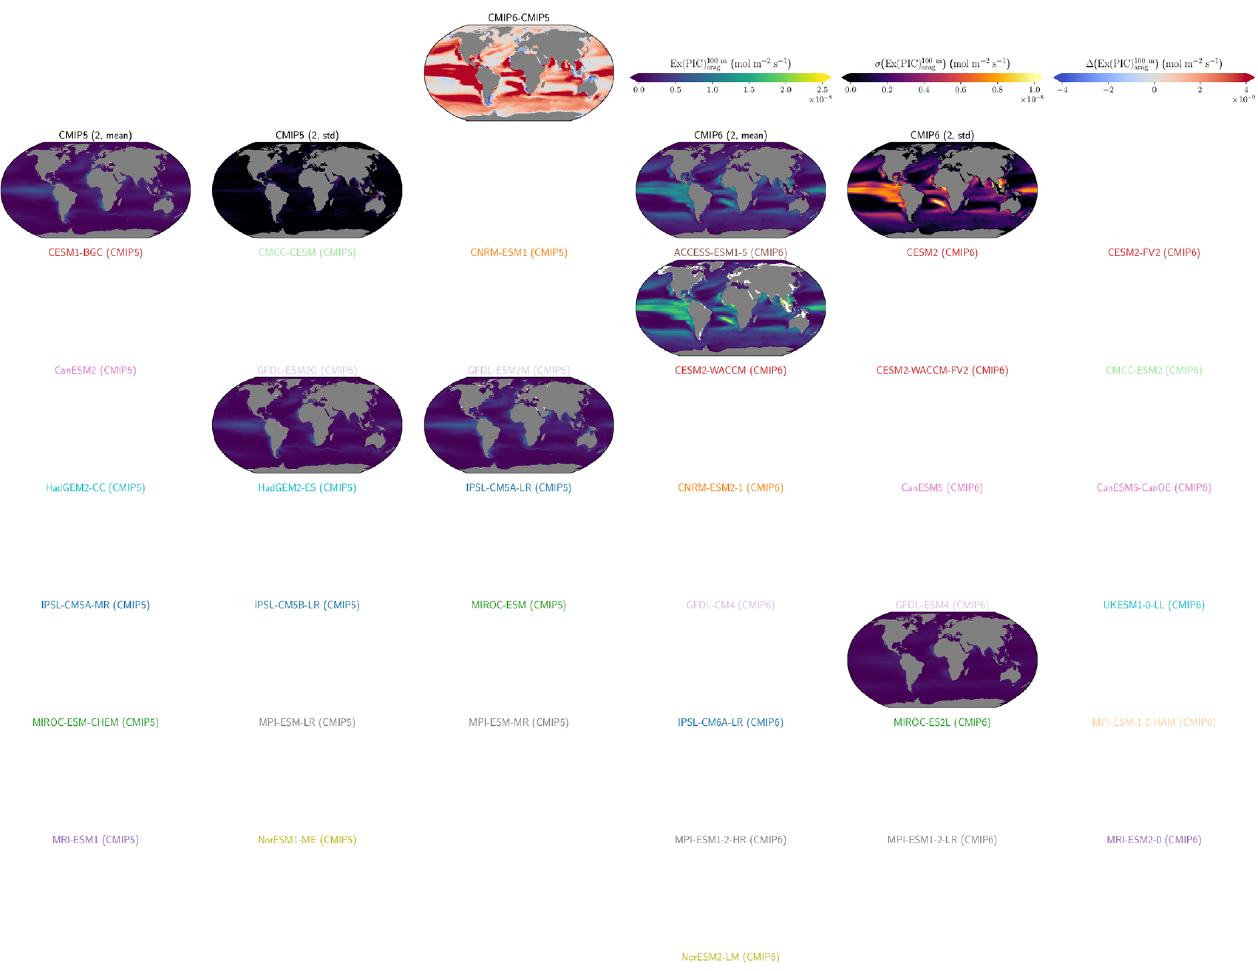
Figure D4. Like Fig. D3 but for the aragonite export at